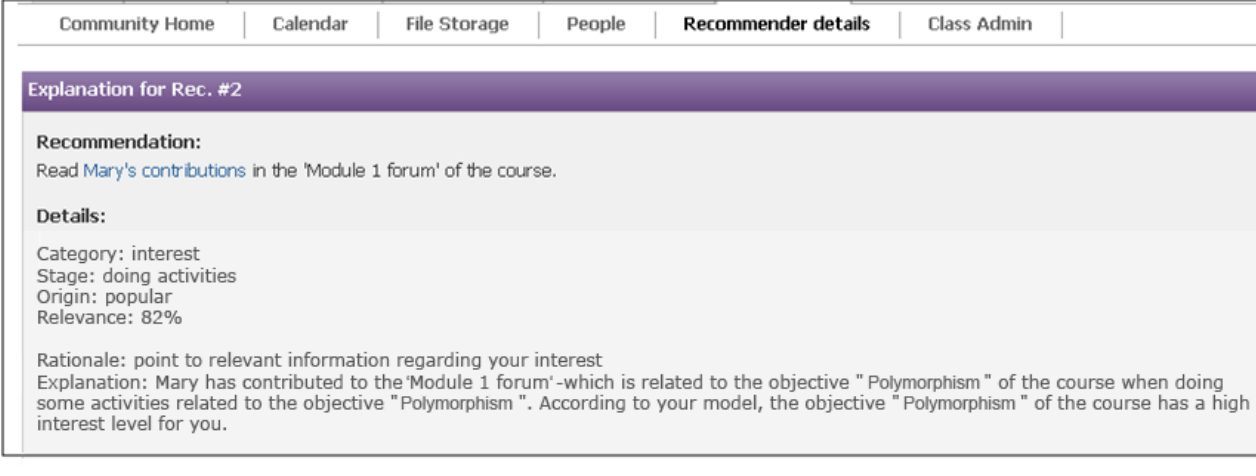
Figure 4. Additional information about each